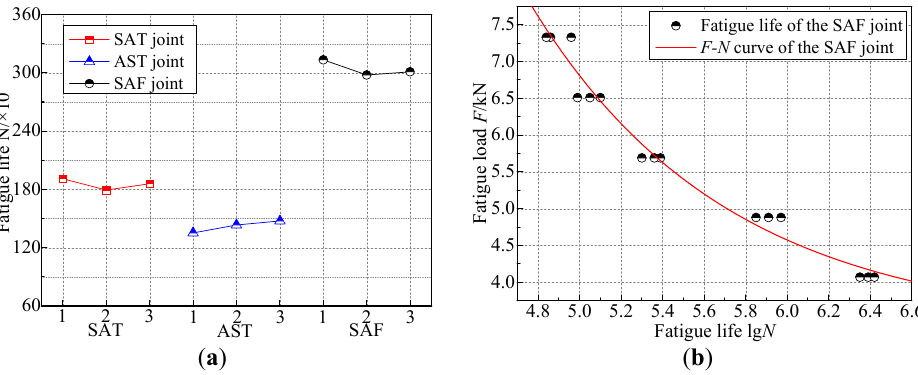
Figure 11. The fatigue life of two-rivet joints. ( a ) A comparison of two-rivet joints; ( b ) F - N curve of the SAF joint.